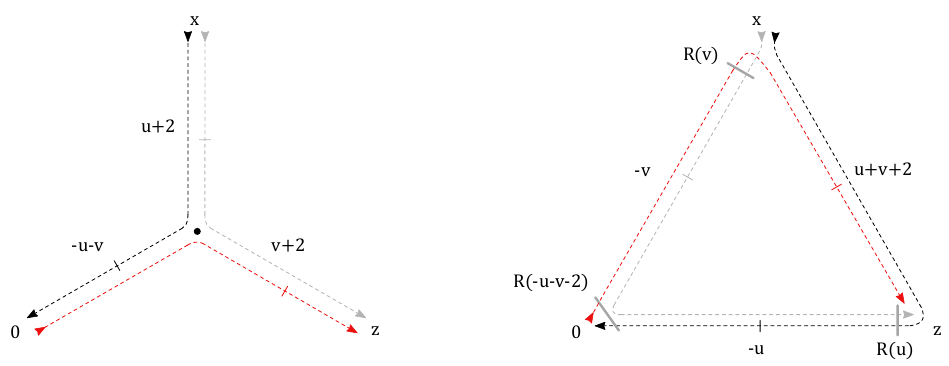
Figure 8 . Diagrammatic representation of the star-triangle duality (2.34)=(2.35). Here the star of conformal propagators (l.h.s.) does not contain any mixing of spinors, which happens only in the triangle (r.h.s.). The arrows denote the order in the matrix products of σ , ¯ σ . Grey solid lines denote R matrices, and the black dot in the star is the integration point. The scaling dimension of each propagator is written next to it.